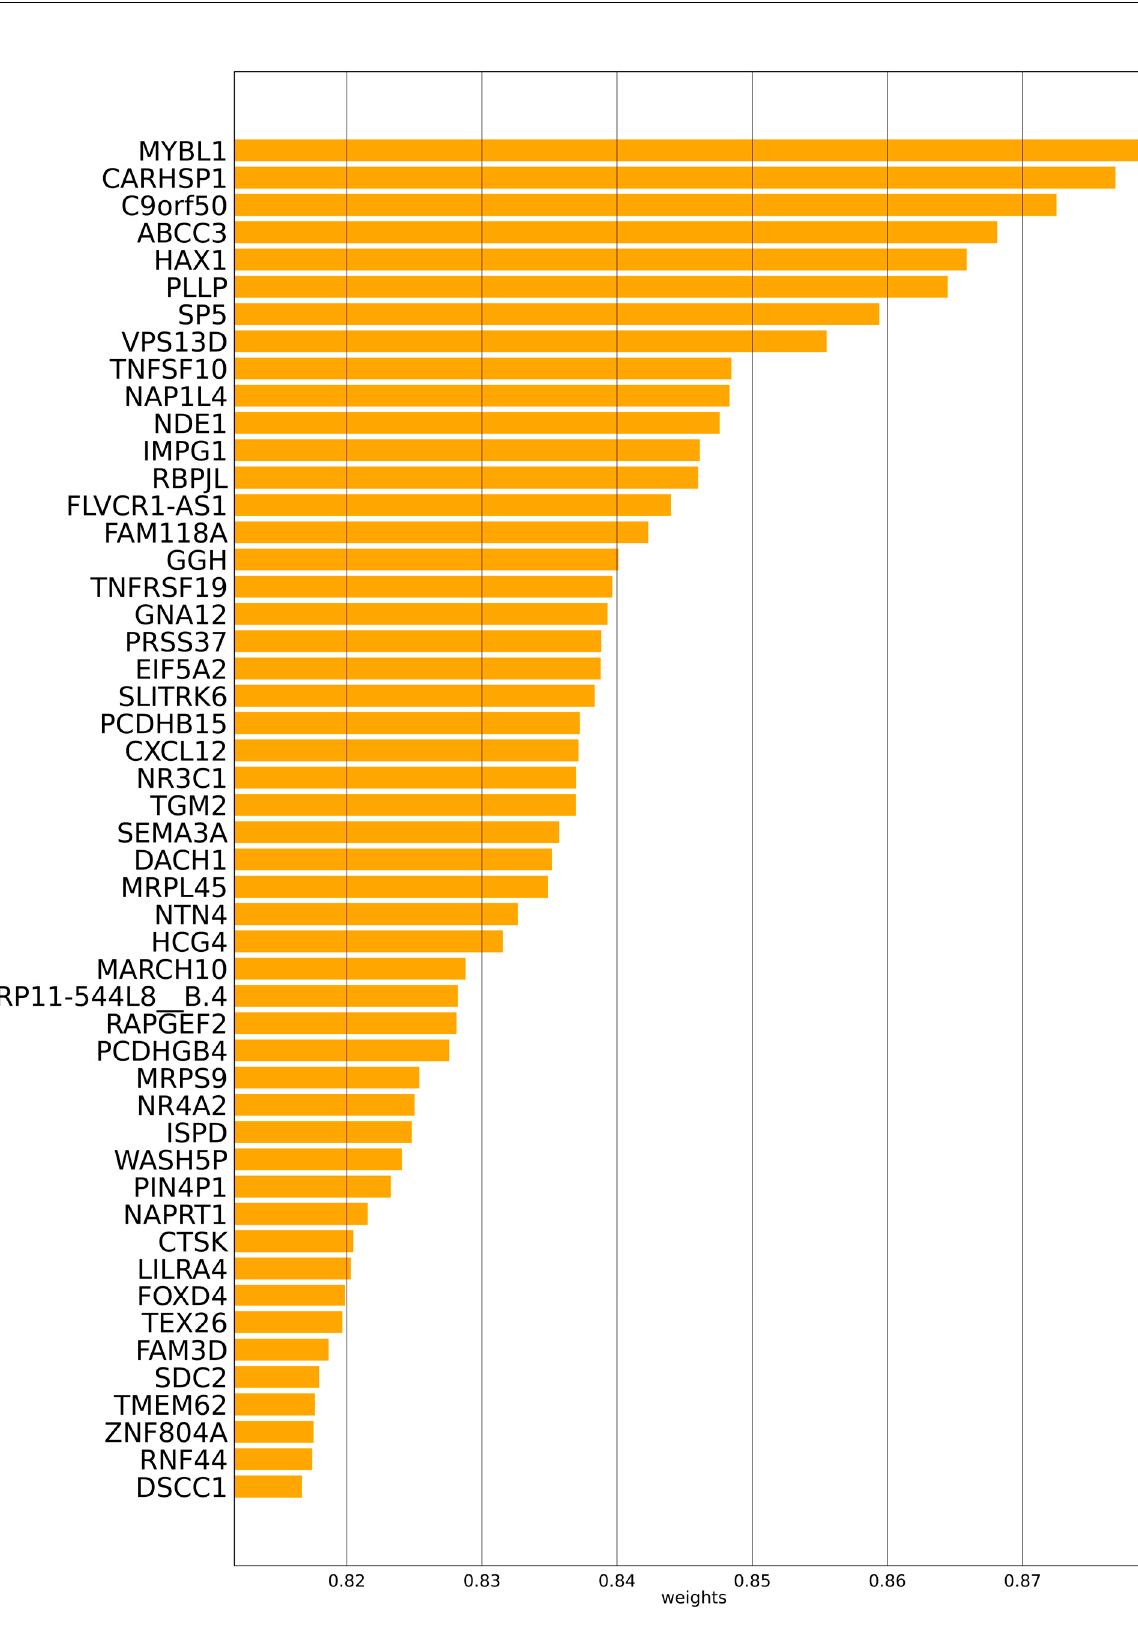
Figure 4. Estimated prognostic mRNAs by Multi-PEN and their attention values.